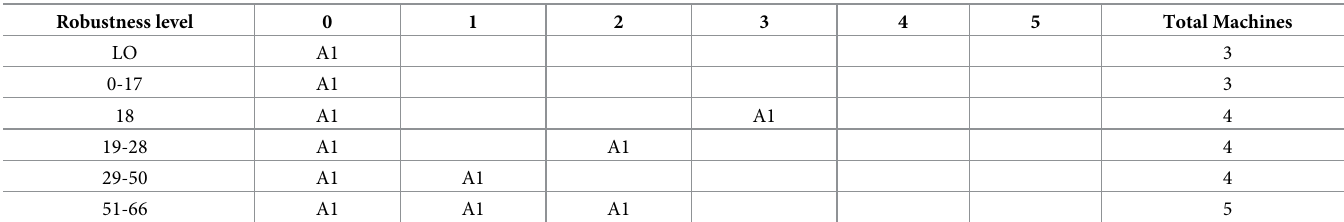
Table 12. Machinery investment during the years.